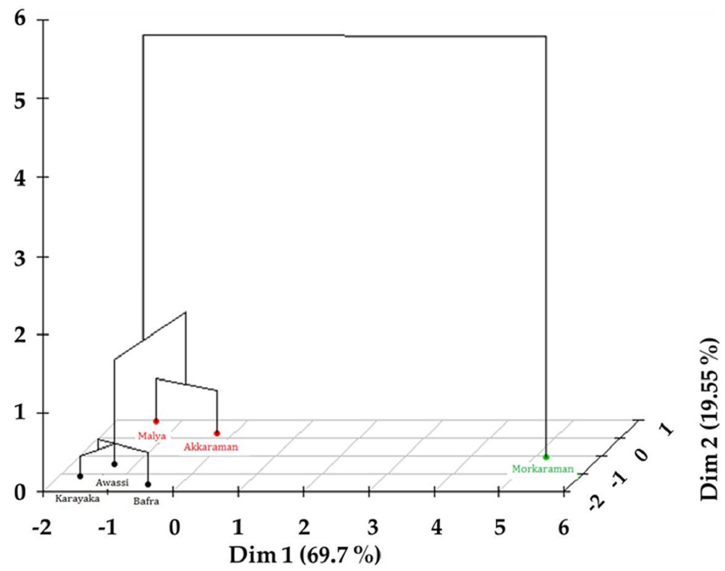
Figure 4. Three-dimensional dendrogram of hierarchical clustering on the factor map.